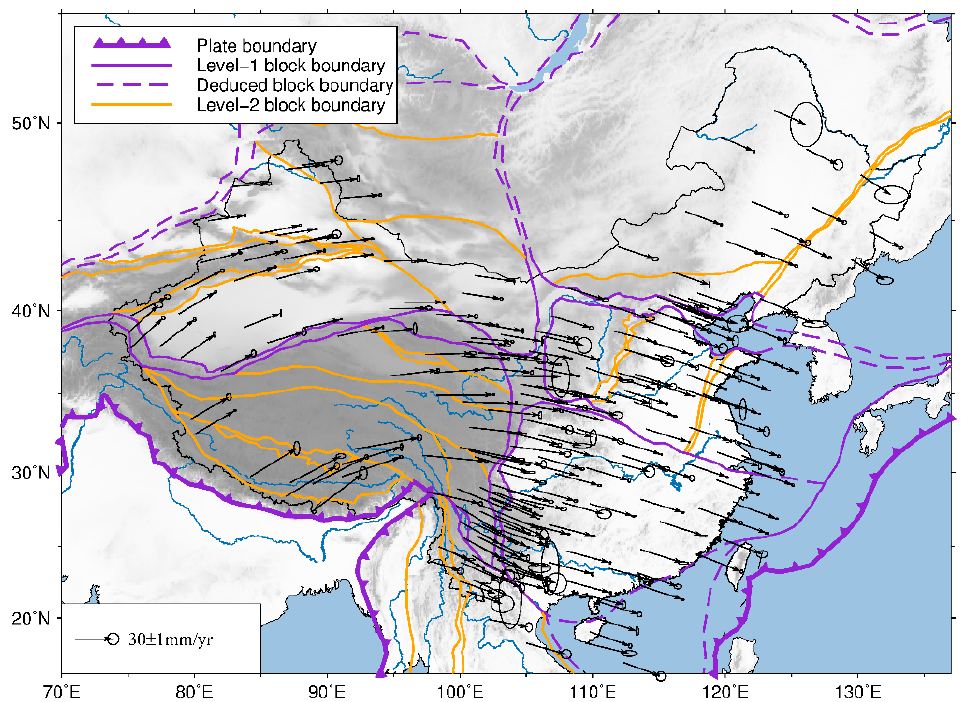
Figure 14. Horizontal velocity field of the CMC filtered CMONOC stations estimated with the PLN + WN model. The reference frame is IGb08. Error ellipses reflect a 95% confidence interval. The tectonic blocks are generated according to Zhang et al. [65].